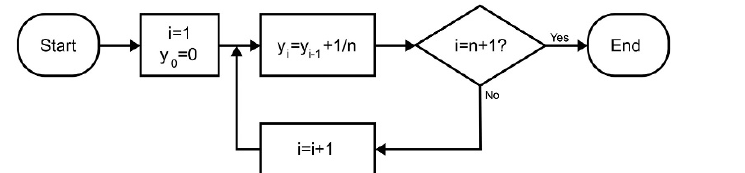
Figure 1. Computation of an IN by algorithm distrIN. All the EEG signal values are n + 1 (sorted) real numbers.